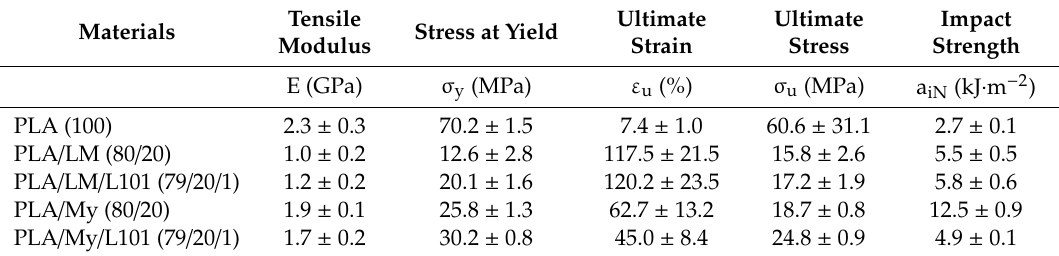
Figure 7. Representative engineering stress vs. engineering strain curves of polylactide (PLA)-based materials obtained in tension at 22 °C and 6 mm·min − 1 (a zoom-in view of the curves highlighting strain levels below 5% was provided). Table 3. Tensile and impact properties of polylactide (PLA)-based materials.